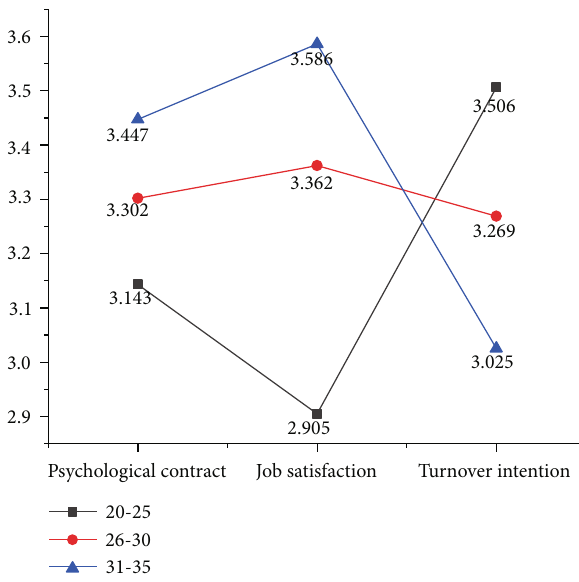
Figure 5: Comparison of the mean values of di ff erent age variables.